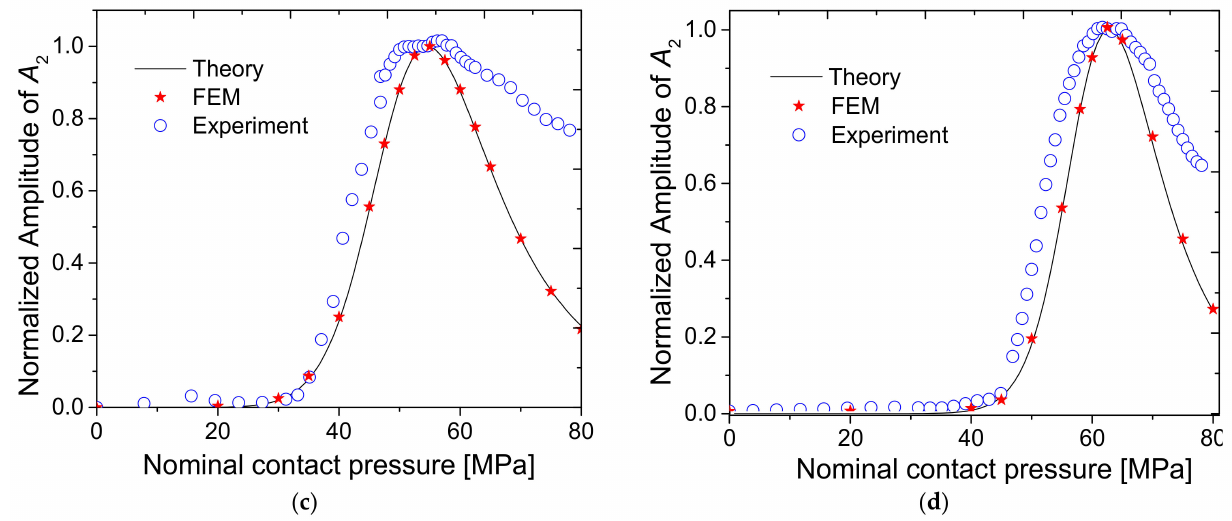
Figure 14. Comparison of theoretical, FEM, and experimental results for A 2 : ( a ) specimen 1, ( b ) specimen 2, ( c ) specimen 3, and ( d ) specimen